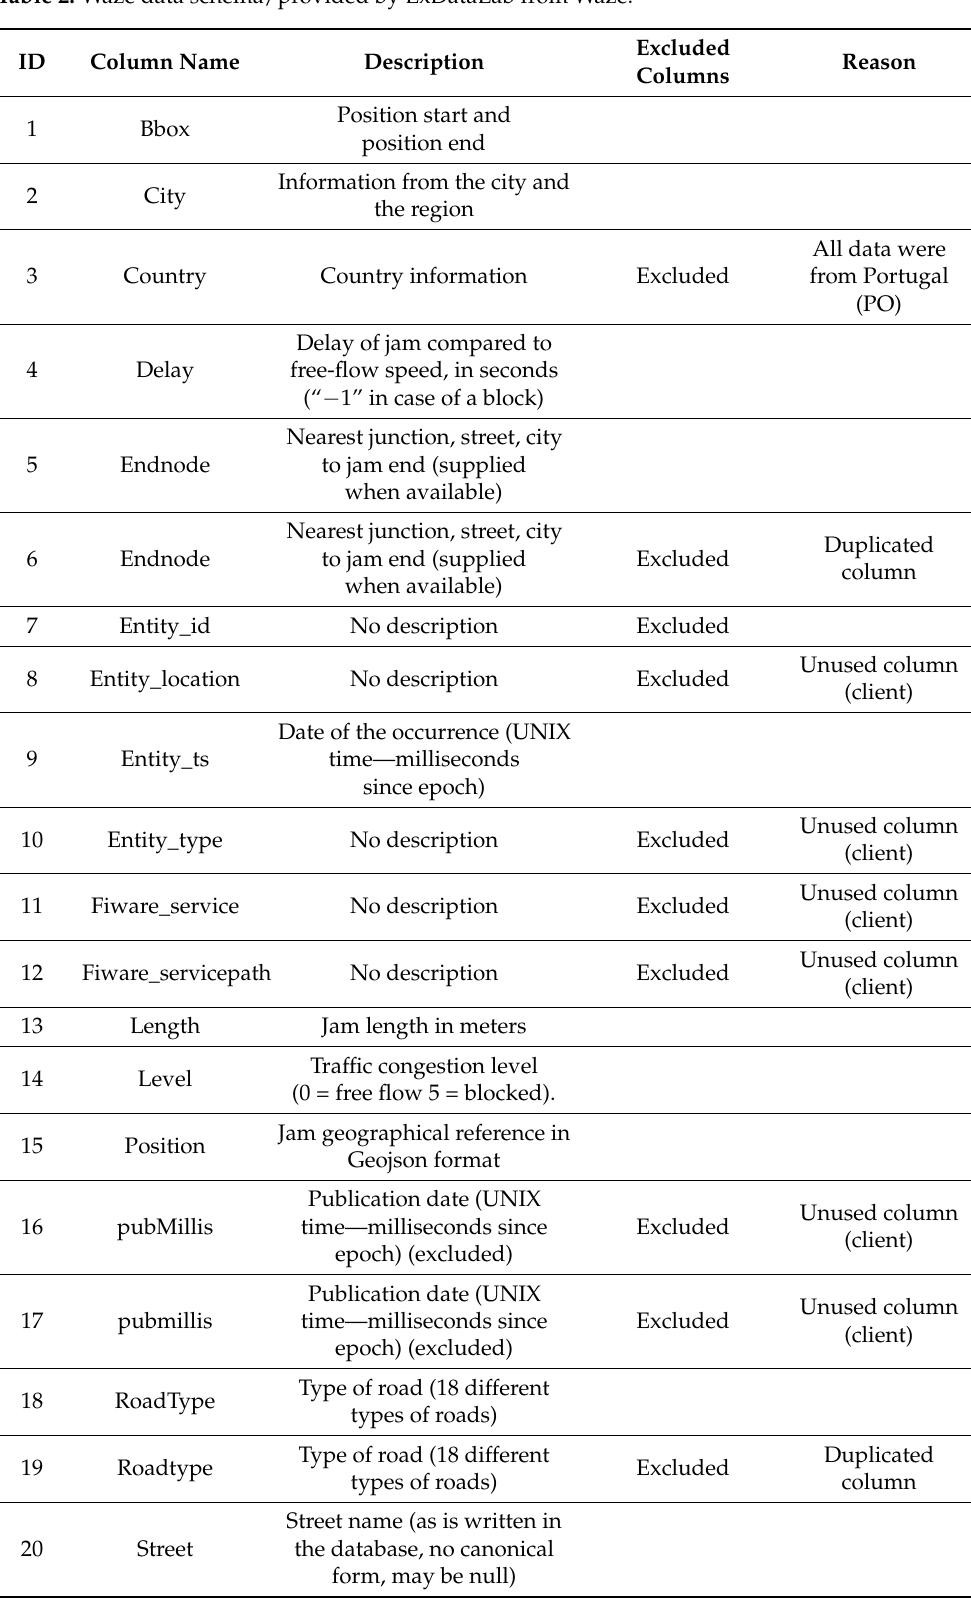
Table 2. Waze data schema/provided by LxDataLab from